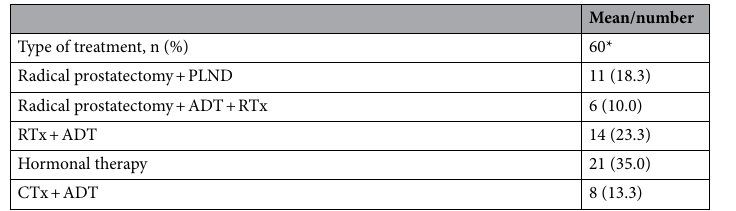
Type of treatment, n